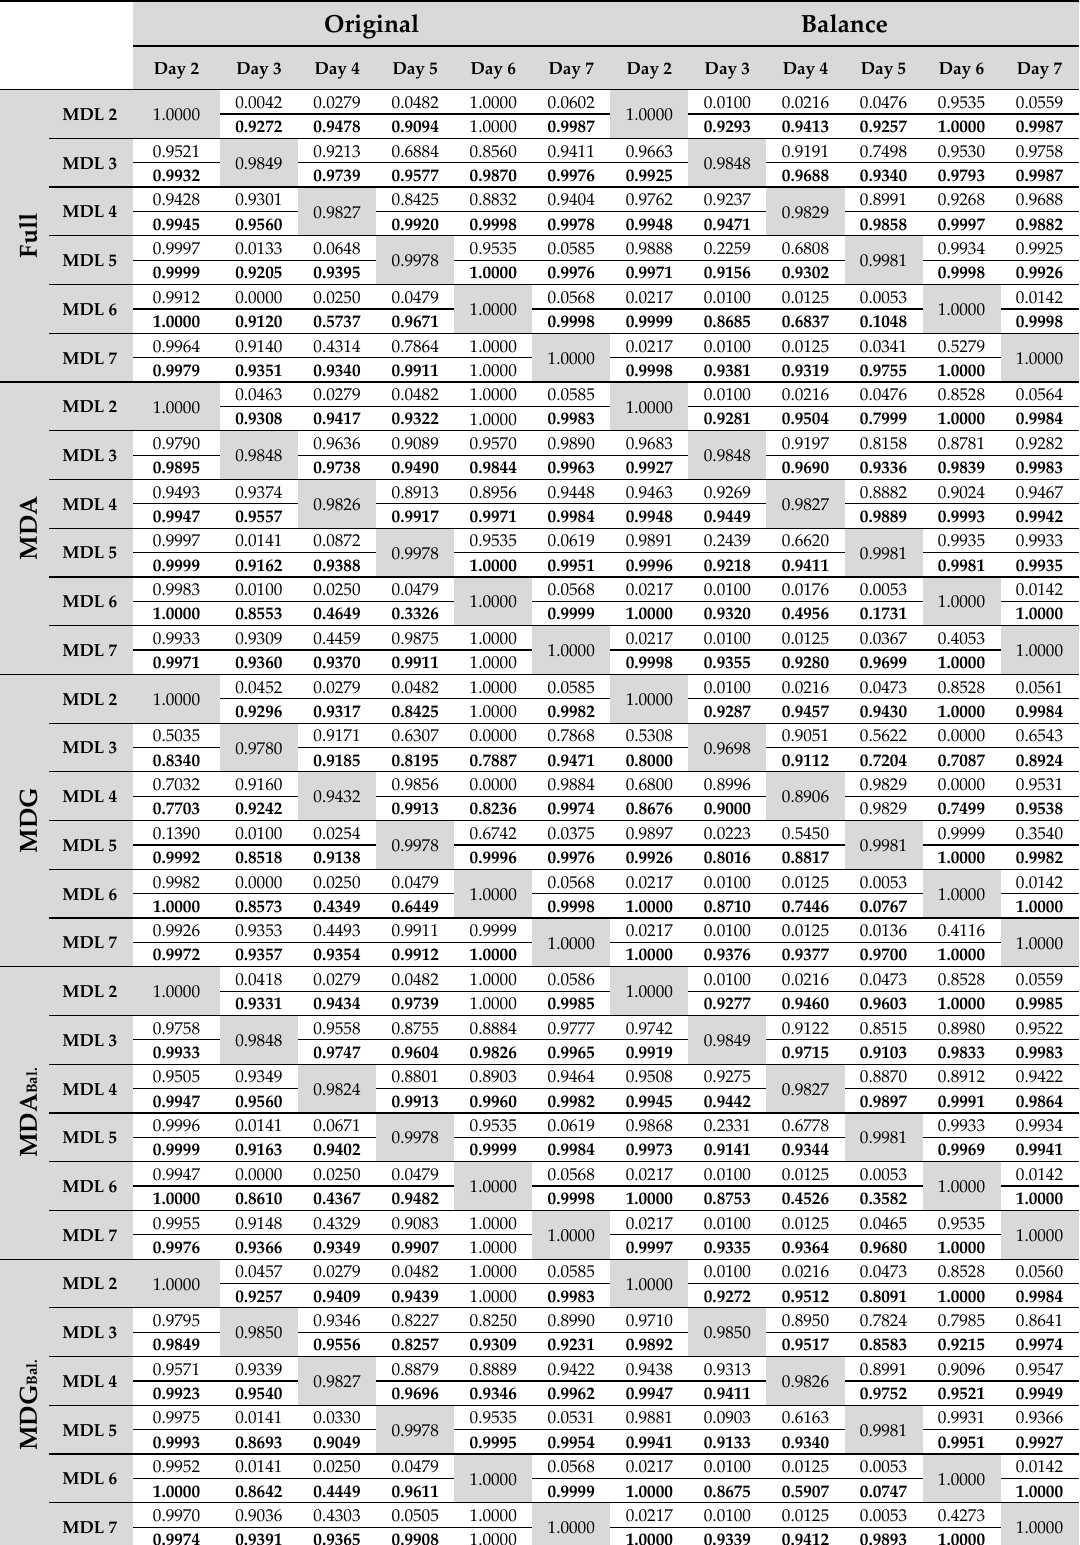
Table A5. The gAcc of models for the fixed optimal (CV) and adapted cut-off (threshold) for the Random Forest (RF) algorithm.